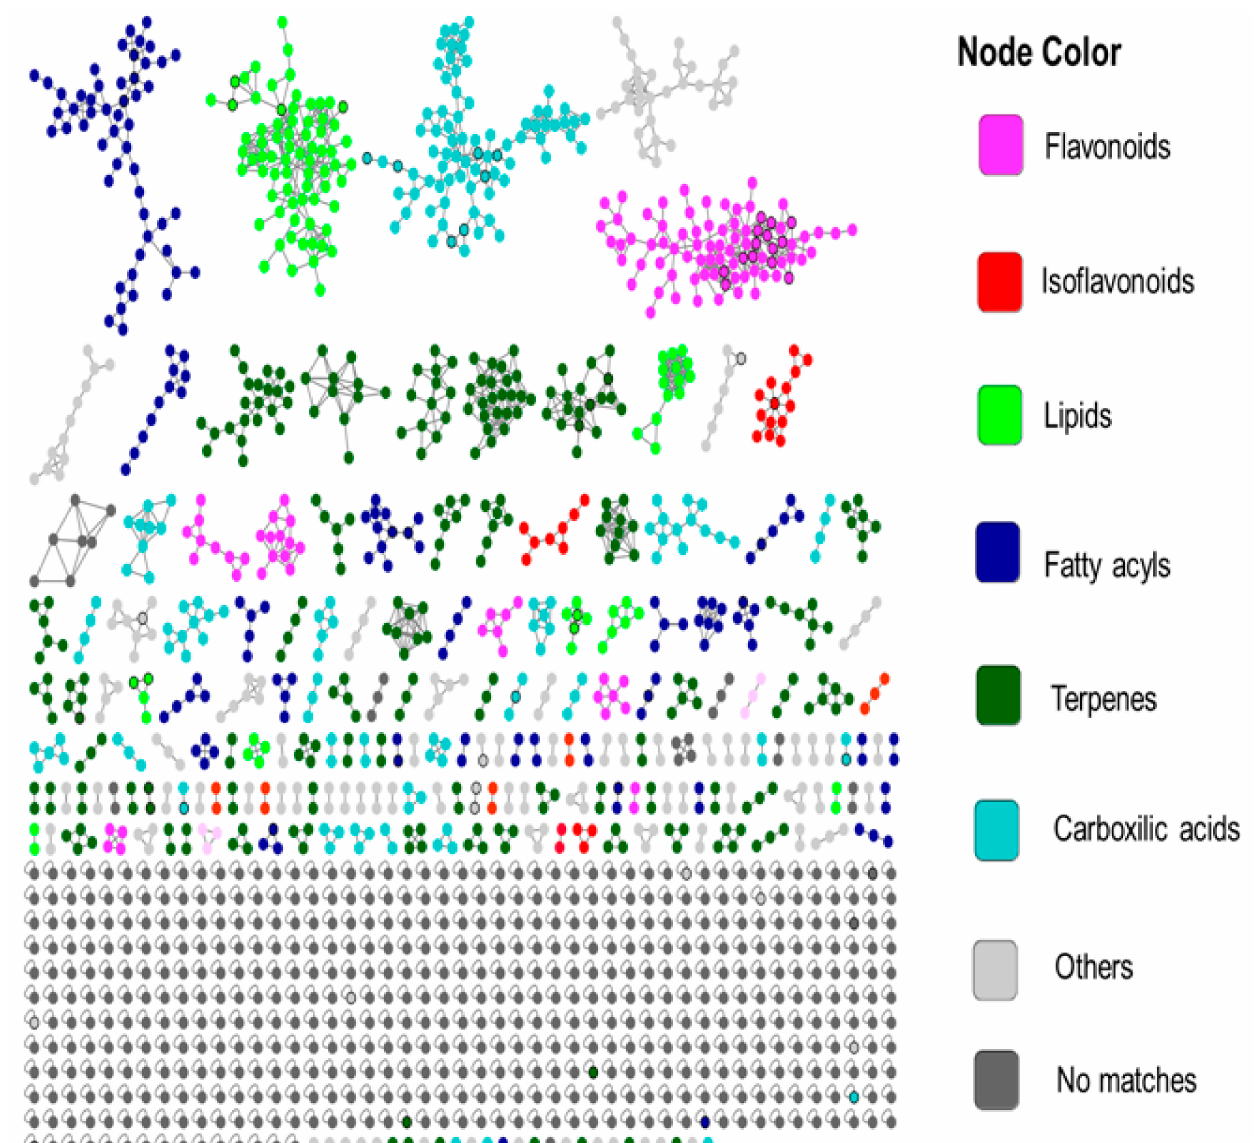
Figure 3. Molecular network of the MS/MS spectra obtained by the analysis of the soybean control plants, or inoculated with P. pachyrhizi colored by 6 chemical class terms selected as indicated in the legend annotated on the molecular network (Supplementary Figure S5) using the MolNetEnhancer. The black bold borders nodes represent the MS/MS spectra that had hits with the spectra of the GNPS